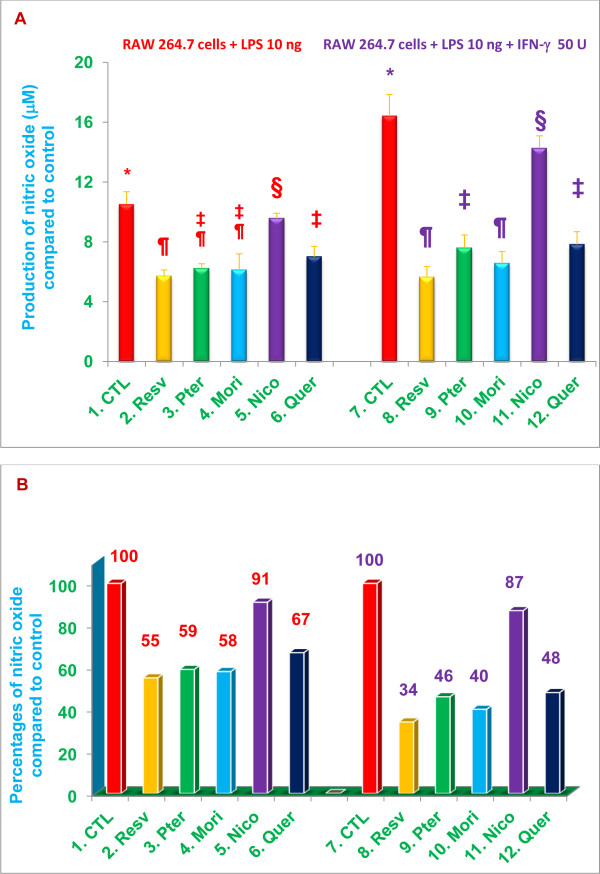
Resveratrol, pterostilbene, morin hydrate, and quercetin inhibit production of NO by RAW 264.7 cells treated with LPS alone, or LPS plus interferon-γ (IFN-γ). NO levels were measured in supernatants of RAW 264.7 treated with resveratrol, pterostilbene, morin hydrate, nicotinic acid, quercetin (16 μM) or medium alone (control) for 1 h, then challenged with LPS (10 ng/well) alone, LPS + IFN-γ (10 ng + 50 U/well) or medium alone (negative control) for 36 h. Cell viability exceeded 95% for all treatments. Data are means ± SD, n = 3 per treatment, and triplicate analyses of each sample were performed. Values in a column not sharing a common symbol are significantly different at P < 0.05. CTL = Control (Medium + RAW 264.7 cells + 0.2% DMSO); Resv = Resveratrol; Pter = Pterostilbene; Mori = Morin hydrate; Nico = Nicotinic acid; Quer = Quercetin-HCL. Figure A = Actual Relative Luminescence Unit (RLU) values. Figure B = Percentages of actual RLU values compared to control.